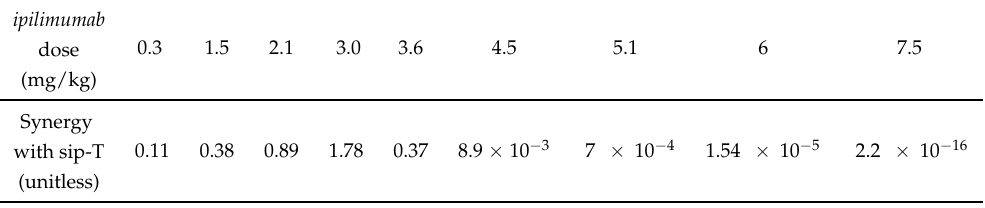
Table A1. Index of synergy between sipuleucel-T (sip-T in the table) and ipilimumab for different ipilimumab doses, computed by the Formula (A6). The two drugs are administered by following the standard procedures. Anti-CTLA4 is administered every 3 weeks, for 4 cycles, while the vaccine is performed by infusing three doses of 50 million of cell every 2 weeks.